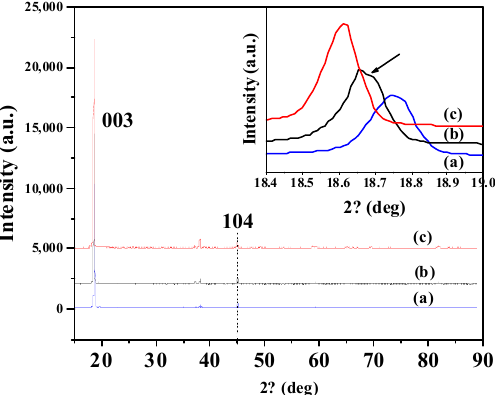
Figure 6. SEM images of LiCoO 2 cycled with a base electrolyte: ( a ) After the first cycle and; ( b ) after 600 cycles; SEM images of LiCoO 2 cycled with the electrolyte containing 0.5% TAIC; ( c ) after the first cycle; ( d ) after 600 cycles. The areas marked in red indicate the byproducts observed.